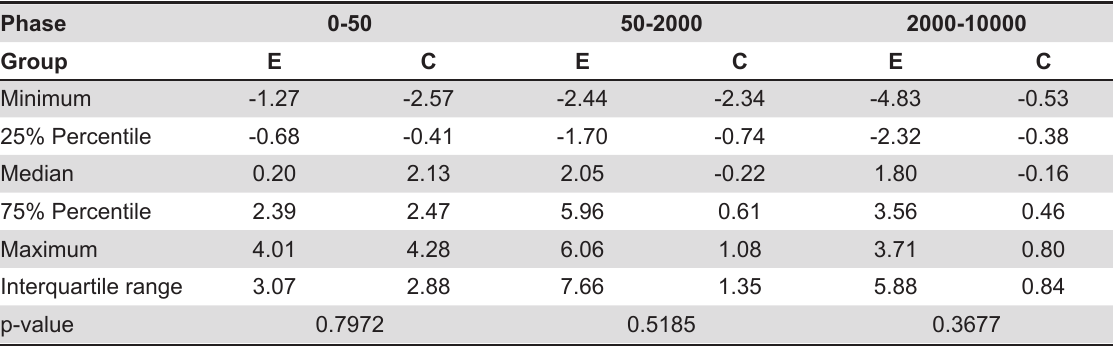
E=electroplated female part, C=cast female Table 4- Descriptive statistics of the force-distance integral changes of the two groups from cycle 0-50, cycle 50-2,000 and 2,000-10000 in N/mm. Negative values stand for a decrease in retention force, positive values for an increase. The p-value for the Mann-Whitney test of the two groups is given